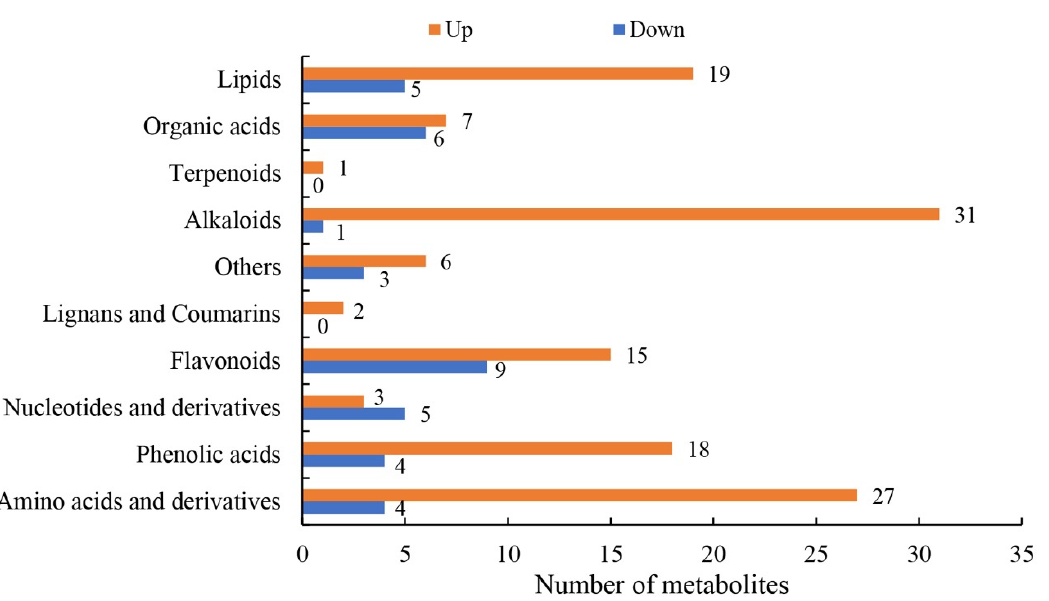
Figure 7. Top 20 enriched KEGG pathways in a comparison of CG and DS metabolomes. 2.4. Combined Transcriptome and Metabolome Analysis To gain insights into gene-metabolite networks that are regulated by DS, we per- formed a combined transcriptome and metabolome analysis. The resulting Venn diagram showed that Biosynthesis of amino acids, Phenylalanine metabolism and Arginine and proline metabolism were common KEGG-enriched pathways in comparisons of CG and